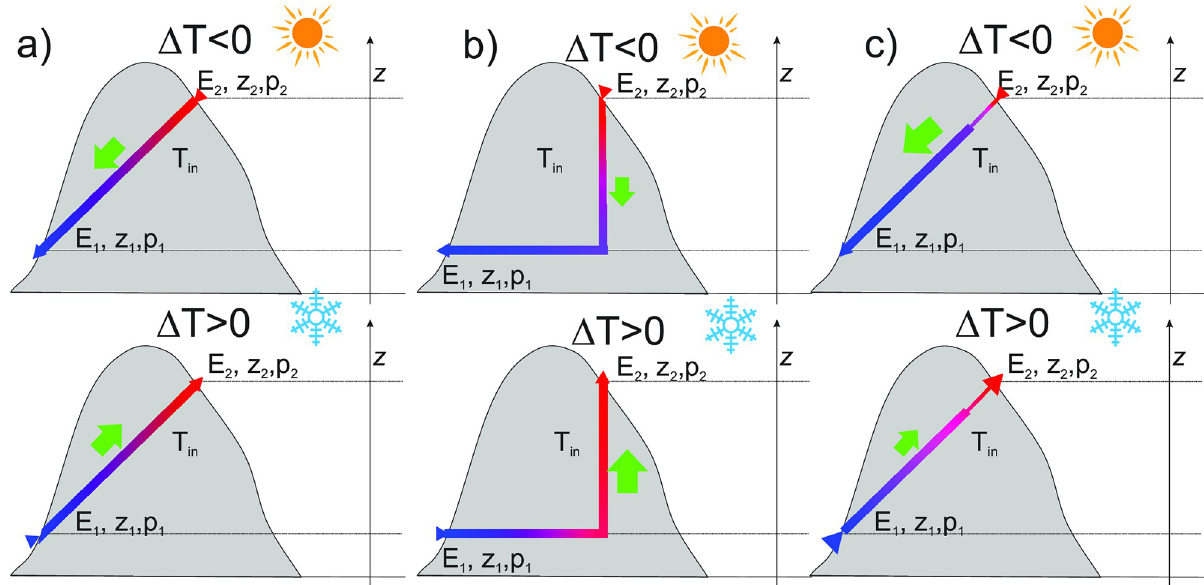
Fig 4. Anticipated airflow direction and magnitude in warm (top) and cold (bottom) periods for different settings. a) Uniform slope and cross-section, b) L-shaped outline, c) Passage with a smaller diameter in the upper section.